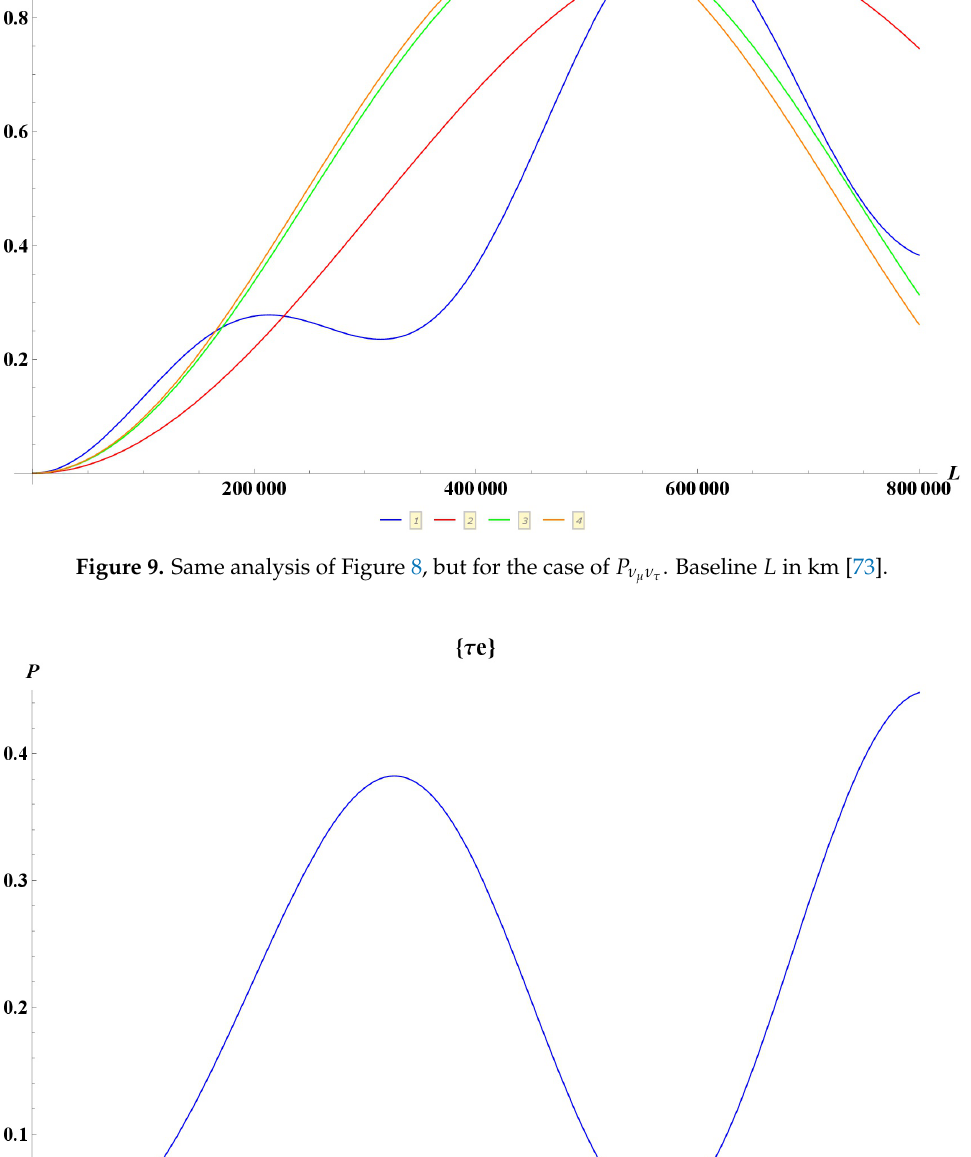
. Baseline L in km e ν τ